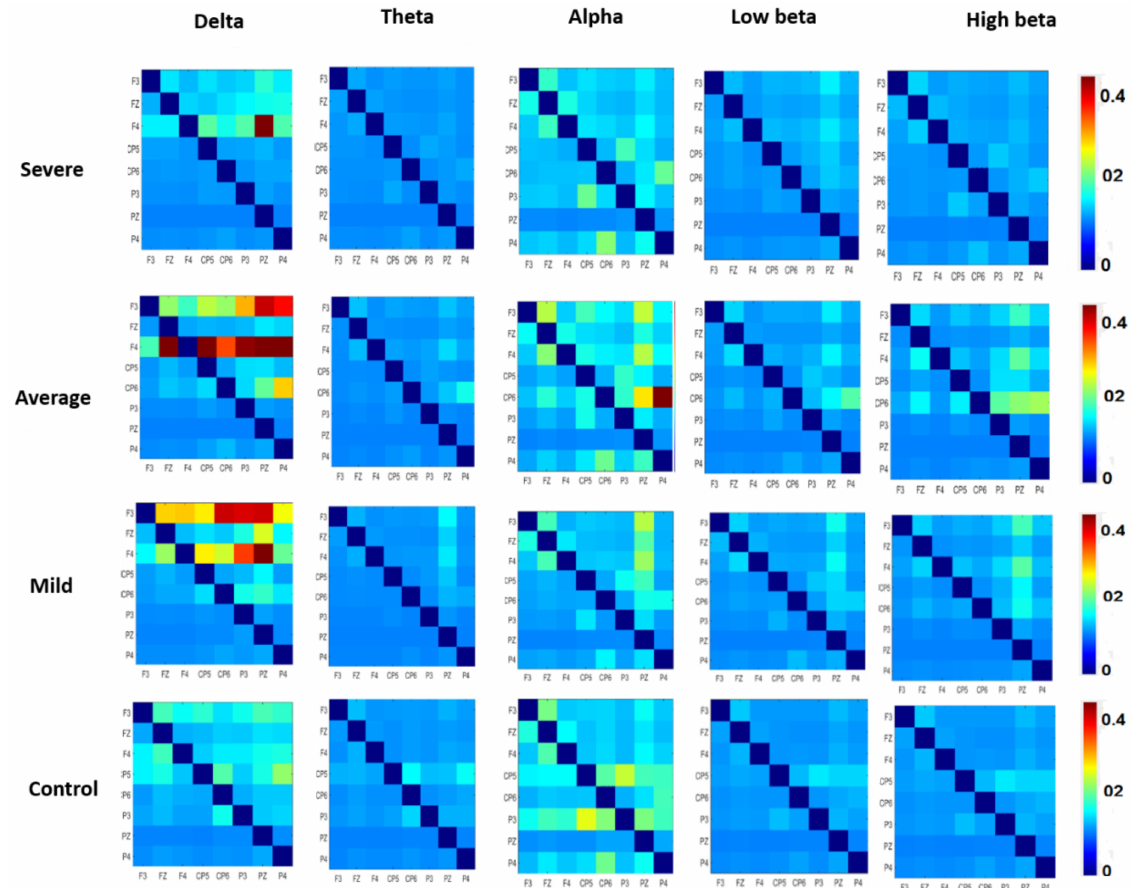
Figure 5. Mean EC intensity matrices of eight DMN neuronal clusters in the resting state. Every component in the matrix represents the mean EC magnitudes for all participants. The information flow can be represented by the flow from the lower rows to the left columns. The red color of the components reflects greater EC significance of the connectivity. Diagonal values are set as